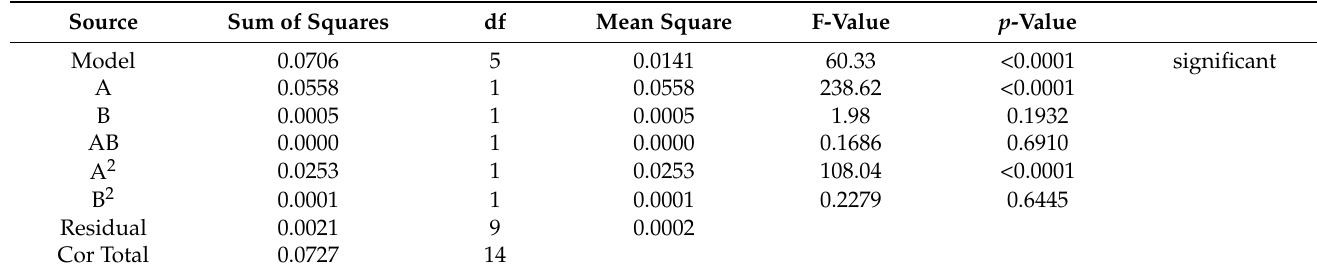
Table 1. ANOVA table for first output response (COP).